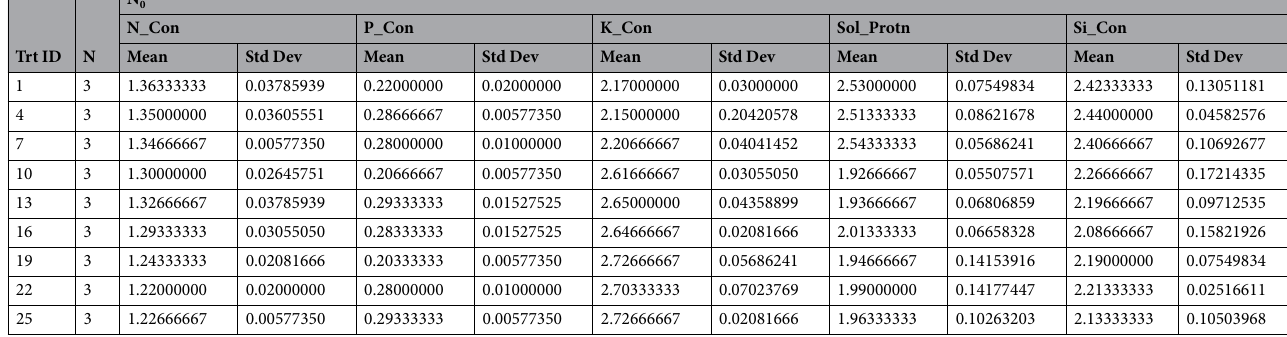
Table 2. Summary statistics from one-way MANOVA of treatment groups for the level of the N factor = 0 units, which are used for multi-dimensional plotting with BPH fitness criteria.